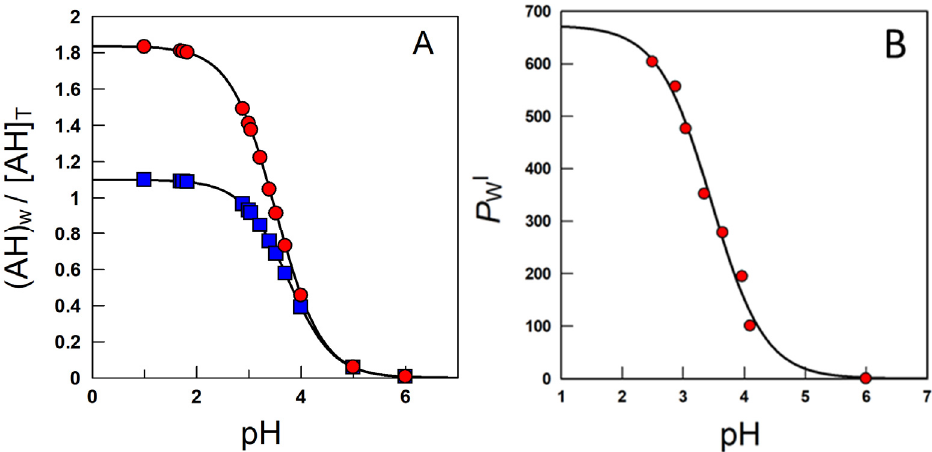
Figure 9. ( A ) Variation with pH of the ratio between the local concentration of the caffeic acid (here represented as AH) in the aqueous region and the total or stoichiometric concentration obtained in corn oil–water systems, T = 25 ◦ C, at two o:w ratios ( (cid:4) —1:9 and • —1:1, v / v ). ( B ) Effects of acidity on the partition constant P WI of caffeic acid in emulsions [58].